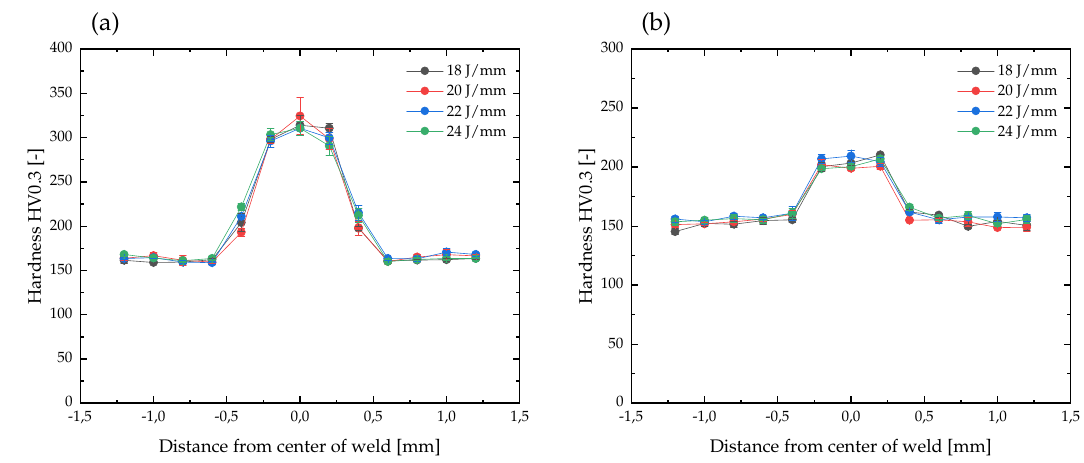
Figure 9. Hardness measurements of ( a ) AISI430 and ( b ) AISI430Ti welded at varying energy inputs. Mean values and standard error of the mean (SEM) calculated from three different